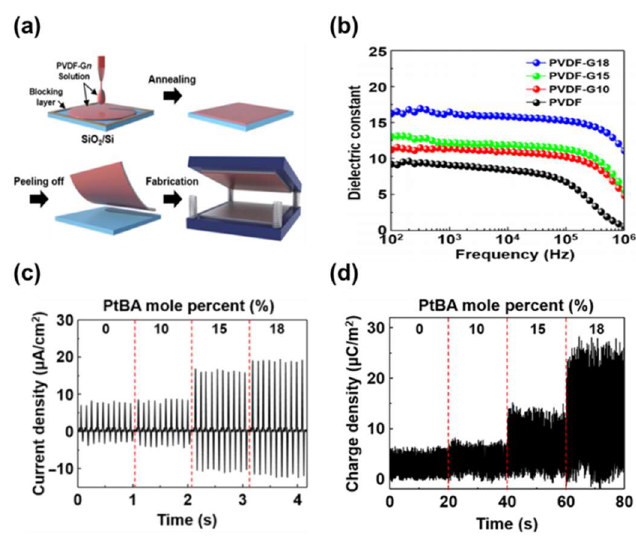
Figure 5. ( a ) The schematic diagrams of the fabrication process for the PVDF-Gn–based TENGs. ( b ) Frequency dependence of the dielectric constant values with various PtBA mole percentages ranging from 0 to 18%. ( c ) Output current densities generated by the PVDF-based TENGs as a function of the PtBA mole percentage ranging from 0 to 18%. ( d ) Charge densities generated by the PVDF-based TENGs as a function of the PtBA mole percentage ranging from 0 to 18%. Reproduced with permission from Baik et al., Sci. Adv. 2017 , 3 , 1500661. Copyright 2017 American Association for the Advancement of Science.